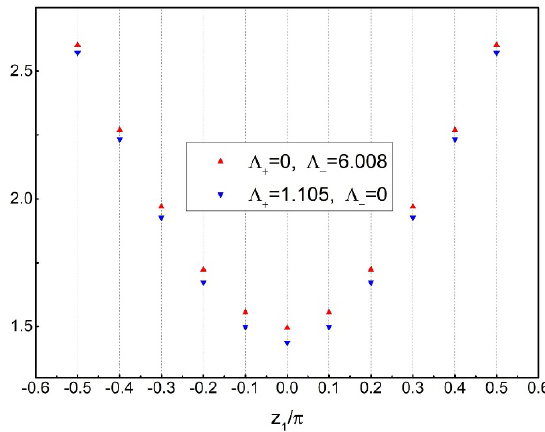
Figure 3 . Lengths of a family of geodesics ( k ) connecting to two target states, in which a single mode is excited, for di(cid:11)erent (cid:12)nal values of the z angle. The red upper triangles represent geodesics reaching the state with y +1 = 0 : 1 ; y (cid:0) 1 = 1 : 1 ; (cid:3) + = 0 ; (cid:3) (cid:0) = 6 : 008. The blue lower triangles are for y +1 = 0 : 1 ; y (cid:0) 1 = 1 : 1 ; (cid:3) + = 1 : 105 ; (cid:3) (cid:0) = 0. In both cases, the minimum value arises at z = 0, i.e., the optimal geodesic corresponds to one of the simple geodesics found in the previous section.